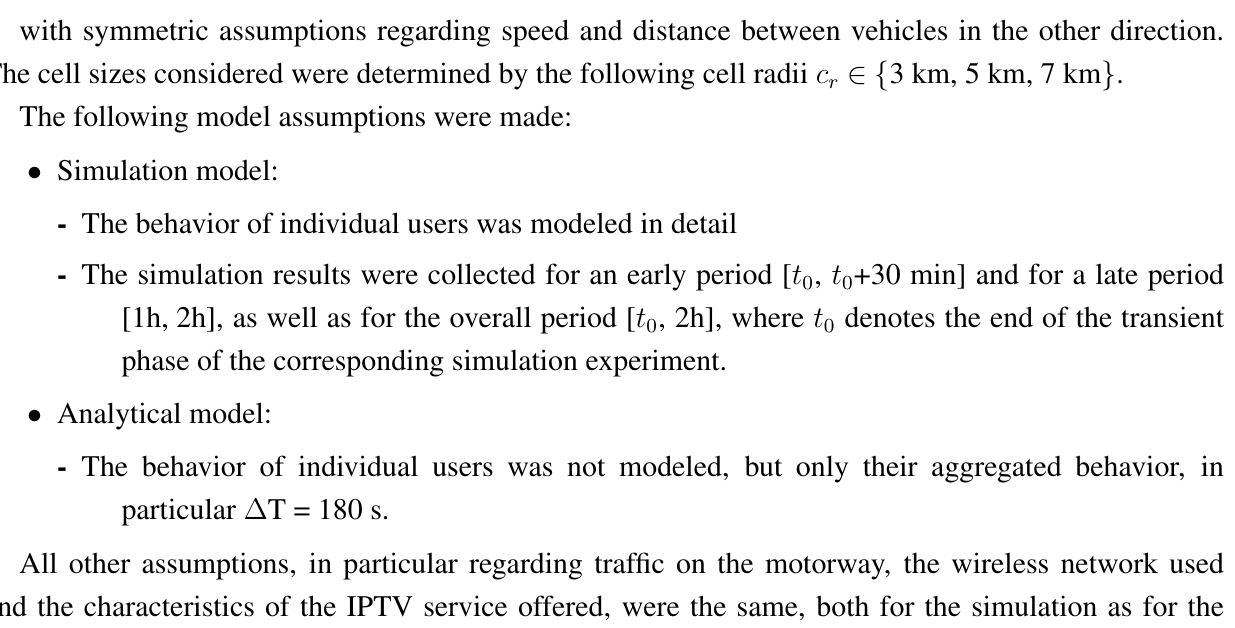
Table 1. The channel blocking probability (CBP) predicted by the analytical models ( AM and AM ) and the simulation model (SM) and the deviations between AM l